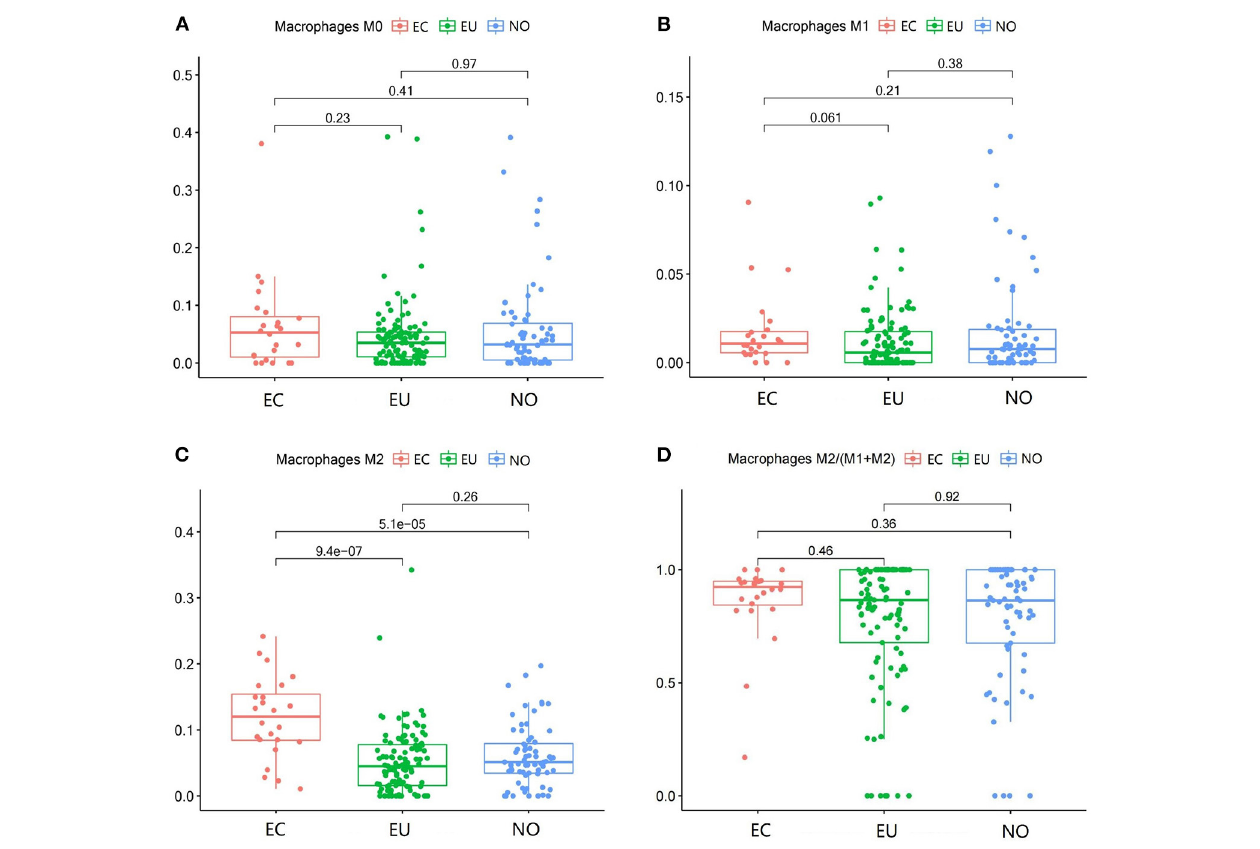
FIGURE 3 | Macrophage subgroups in EC, EU, and NO. CIBERSORT immune cell fractions were determined for each patient; each dot represents one patient. The upper quartile (P25), median value, lower quartile (P75) after removing datas with large deviation for each cell subset, including M0 macrophages (A) , M1 macrophages (B) , M2 macrophages (C) , and M2 macrophages/ (M1 macrophages + M2 macrophages) (D) , were calculated for each patient group and compared using the Kruskal-Wallis test. Y axes represent the composition ratio of each immune